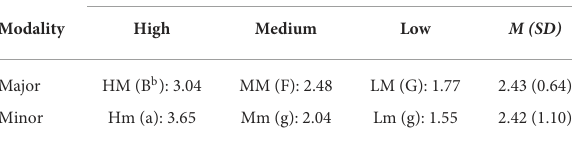
TABLE 1 The intervallic complexity of each score identified with the left letter as the level of complexity and the right letter as modality. Intervallic